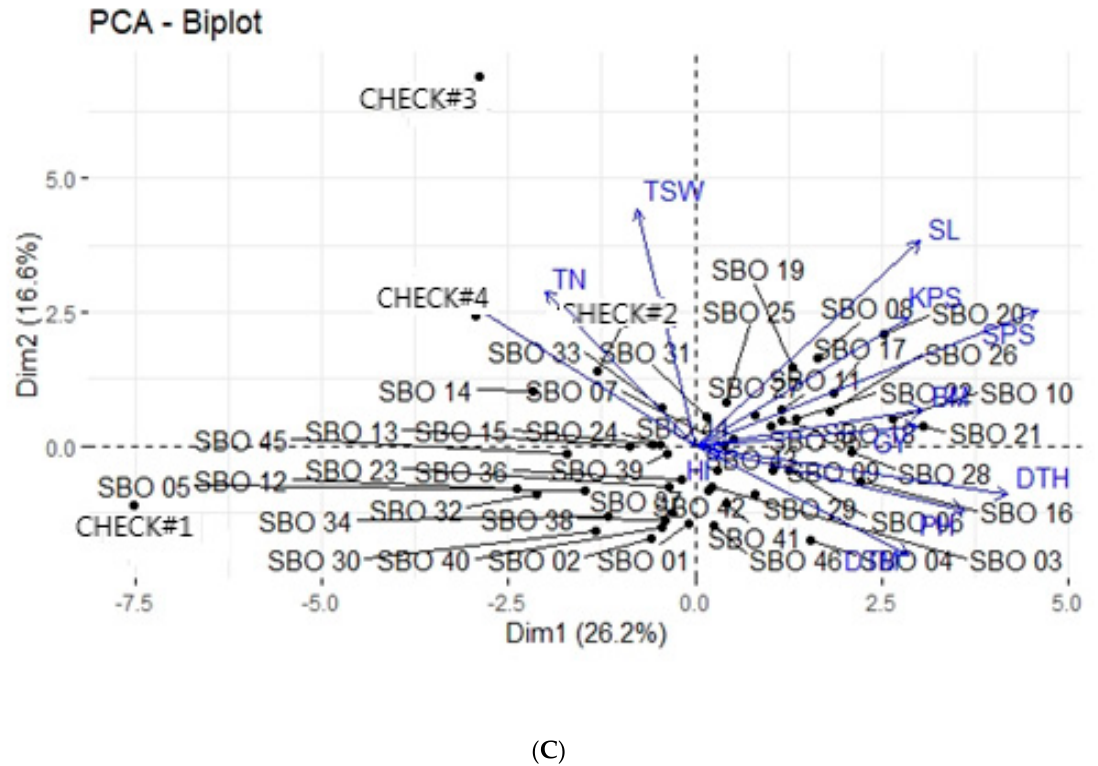
Figure 1. Principal component biplot showing genotypic grouping under drought-stressed conditions and at three nitrogen levels (( A ), 50 kg ha − 1 ; ( B ), 100 kg ha − 1 and ( C ), 200 kg ha − 1 ). SE, number of seedlings emerged; DTH, days to 50% heading; DTM, days to maturity; PH, plant height (cm); TN, number of productive tillers; SL, spike length (cm); SPS, number of spikelets per spike; KPS, number of kennels per spike; TSW, thousand seed weight (g/1000 seed); GY, gain yield (g/m 2 ); BM, biomass (g/m 2 ); HI, harvest index. See codes of genotypes in Table 1.